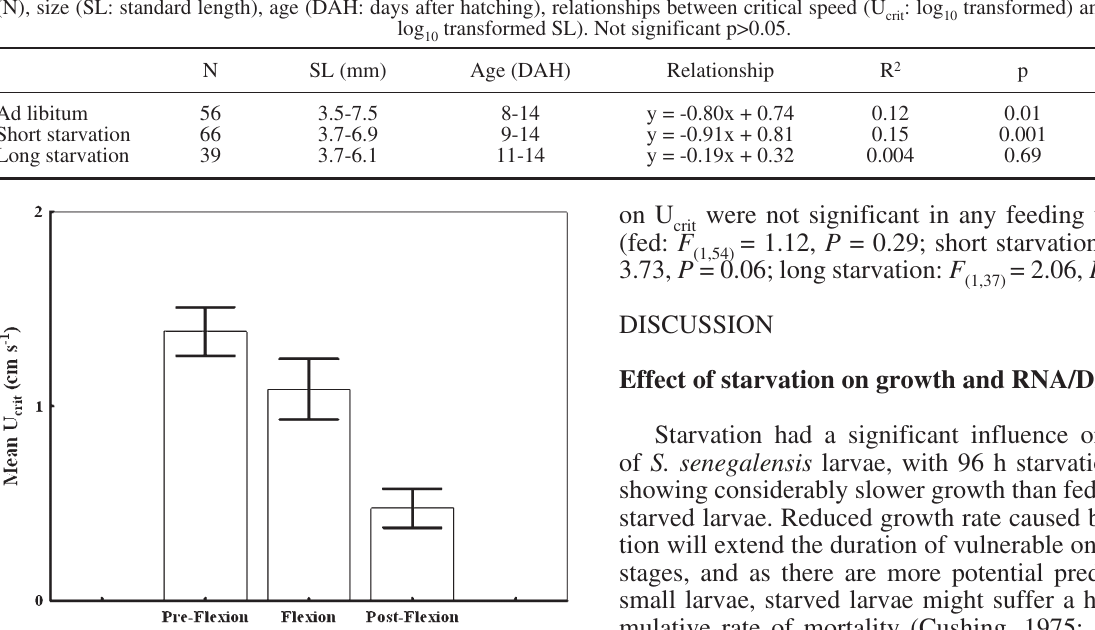
Table 2. – Summary of measurements of critical swimming speed (cm s -1 ) for S. senegalensis in the different feeding treatments: Number (N), size (SL: standard length), age (DAH: days after hatching), relationships between critical speed (U